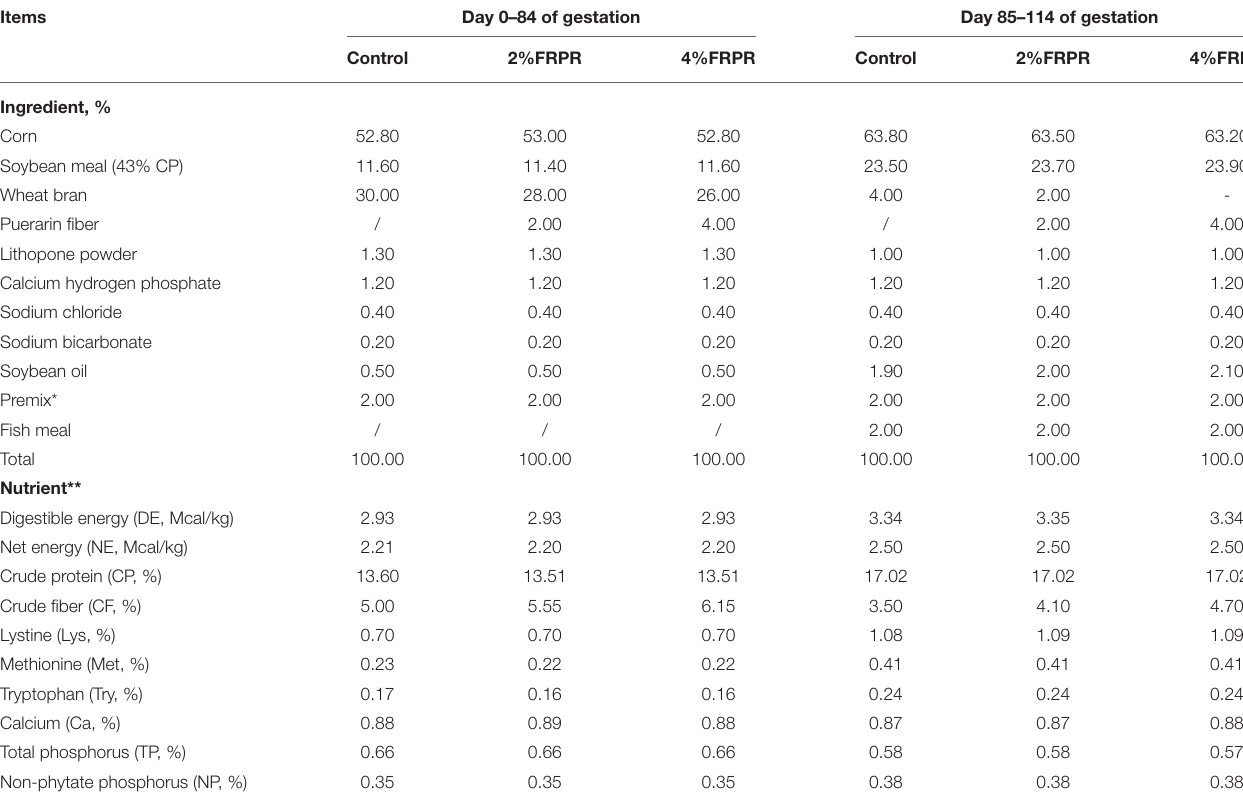
TABLE 1 | Ingredient composition of diets in early and later stages of pregnancy.